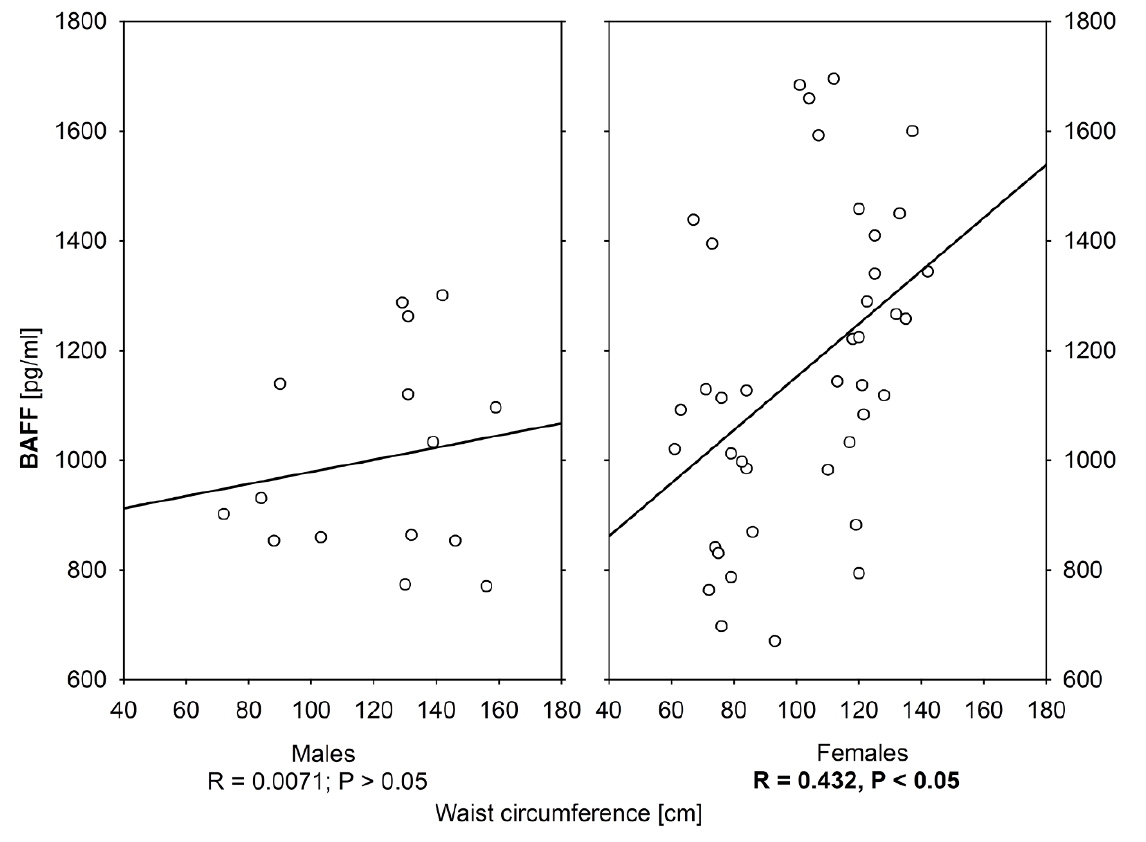
Figure 3. Correlation between BAFF and waist circumference by gender. The correlation coefficient was determined using the Pearson’s test; the observed trend is indicated by the solid